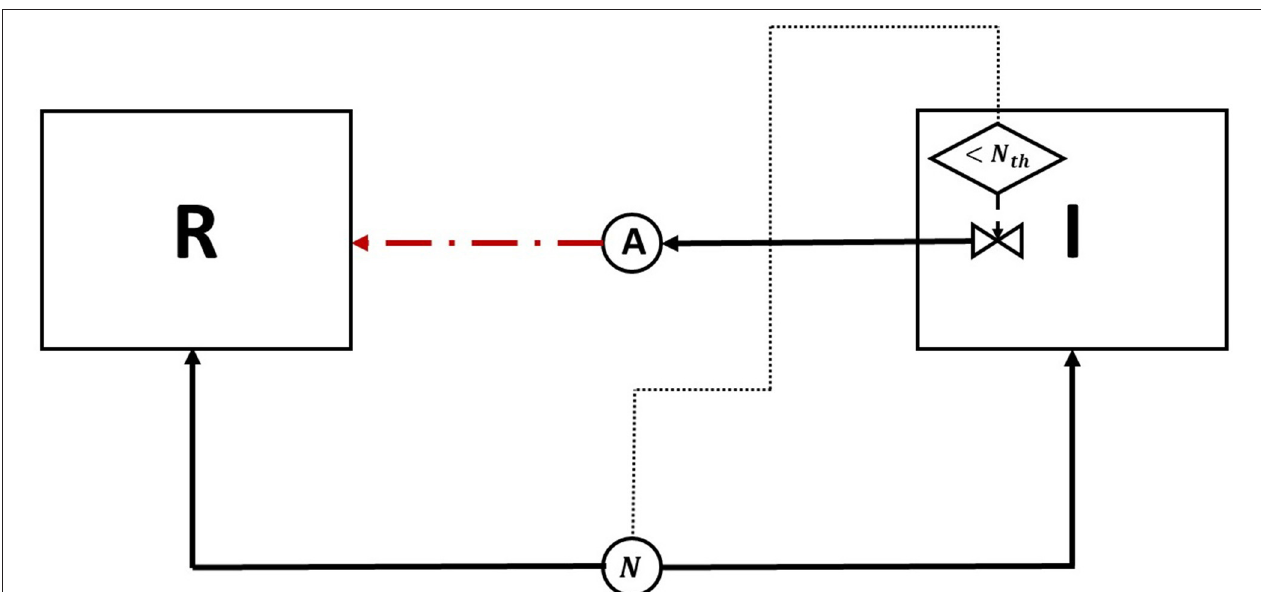
FIGURE 1 | A diagram of the competition between an antibiotic producing invader vs. a resident species, competing over a single nutrient. The change in nutrient utilization strategy by the resident species in response to competition with a nutrient stress regulated invader is examined. The diagram depicts two biological species: the invader ( I ) and the resident ( R ), both enclosed in a square, and two chemical species, a nutrient ( N ) and an antibiotic ( A ), denoted by circles. The consumption of N by I and R , as well as the production of A by I are all denoted by solid lines. The growth inhibiting effect of A on R is denoted by a dashed line. Finally, the production of A by I is regulated by nutrient stress. This is represented by a decision flowchart where I senses the nutrient concentration, this action is represented by a dotted line, and it activates the production of A only when it falls below a threshold concentration N th